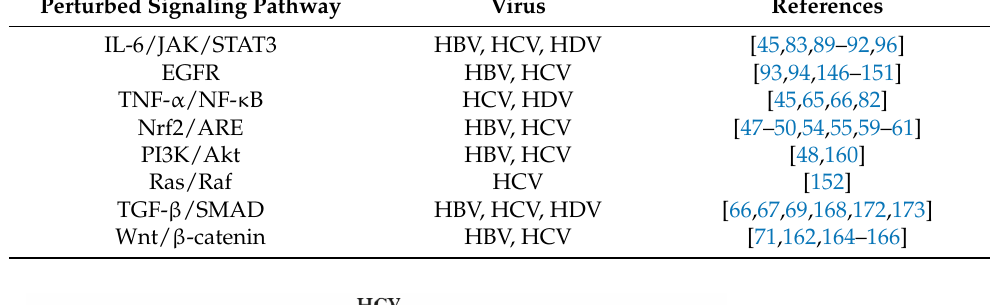
Table 1. Virus-perturbed signaling pathways during chronic viral hepatitis. Perturbed Signaling Pathway